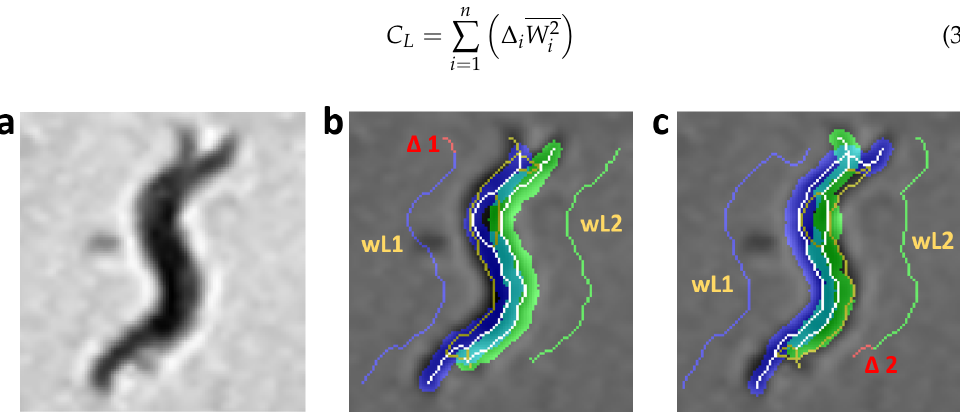
Figure 4. Length criterion evaluation. The pixels in red are the length error. The yellow and white pixels are the resulting skeleton using the improved form of skeletonizing. The white pixels are the pixels of the skeleton prediction, which are used to reconstruct the body of each worm (segmentation in blue and green). ( a ) Grayscale image. ( b ) Length criterion evaluation with length error in worm1 (blue). ( c ) Length criterion evaluation with length error in worm2 (green).